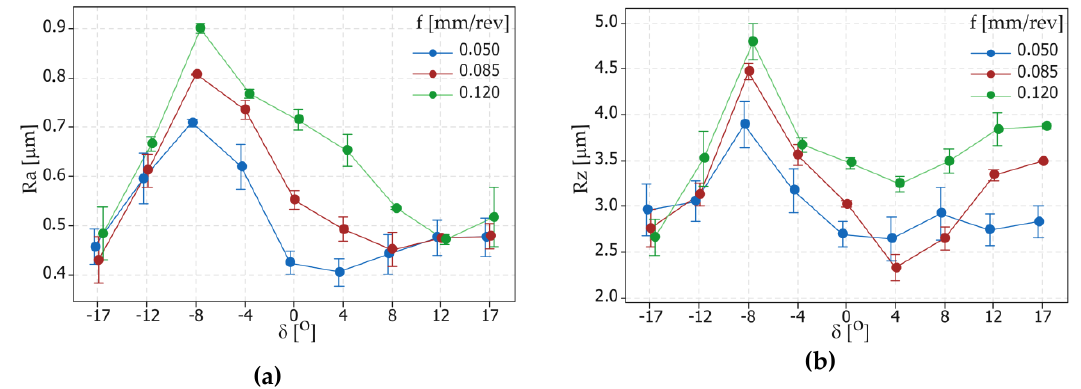
Figure 5. Graphs representing the relation between the tilted angle δ and surface roughness parameters: ( a ) Ra and ( b ) Rz; for different feed rate f values.